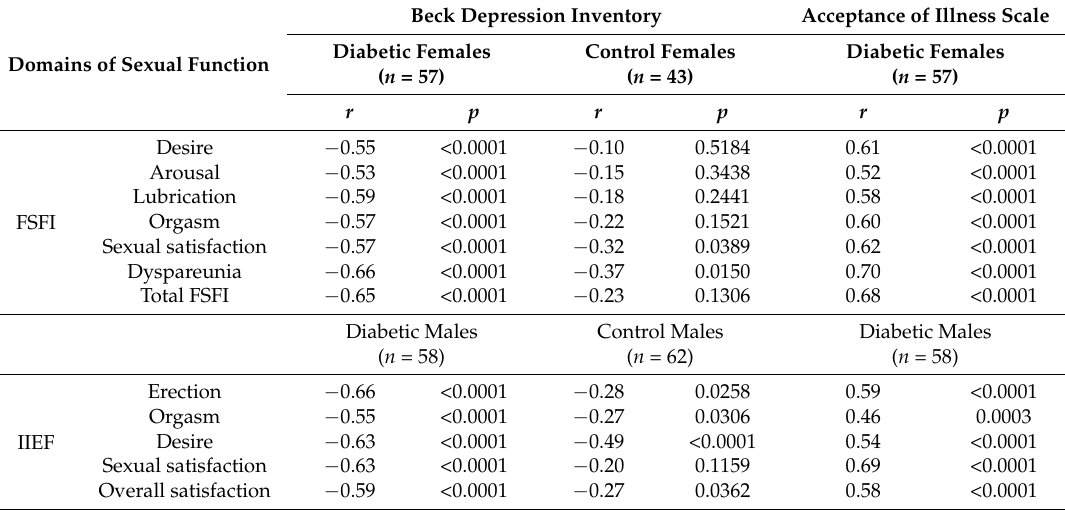
Table 6. The relationship between the Female Sexual Function Index (FSFI) or the International Index of Erectile Function (IIEF) and the Beck Depression Inventory and the Acceptance of Illness Scale.